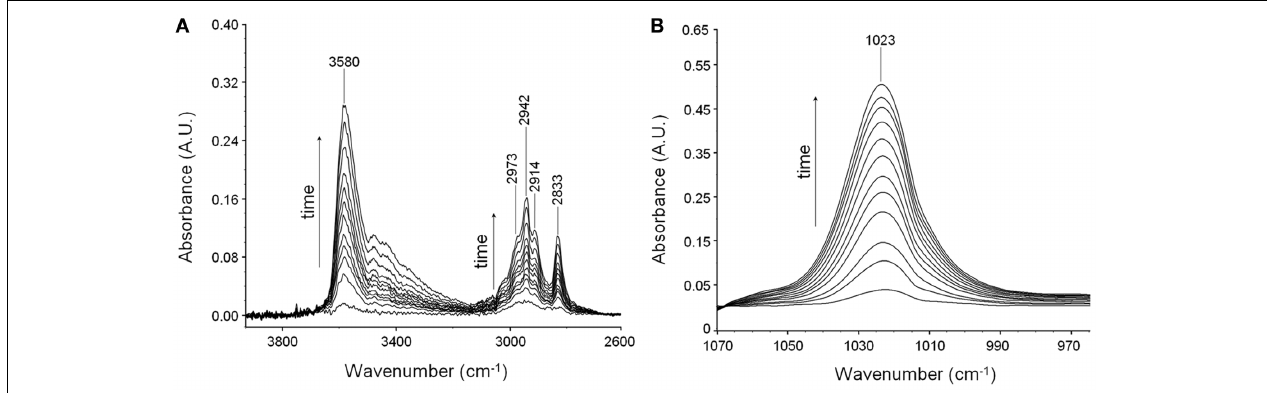
Figure 2 | Difference spectra collected at increasing times during a sorption experiments of methanol in PMDA-ODA at p / p 0 = 0 . 3. (A) Wavenumber range 4000–2700cm − 1 . (B) Wavenumber range 1060–970cm − 1 .